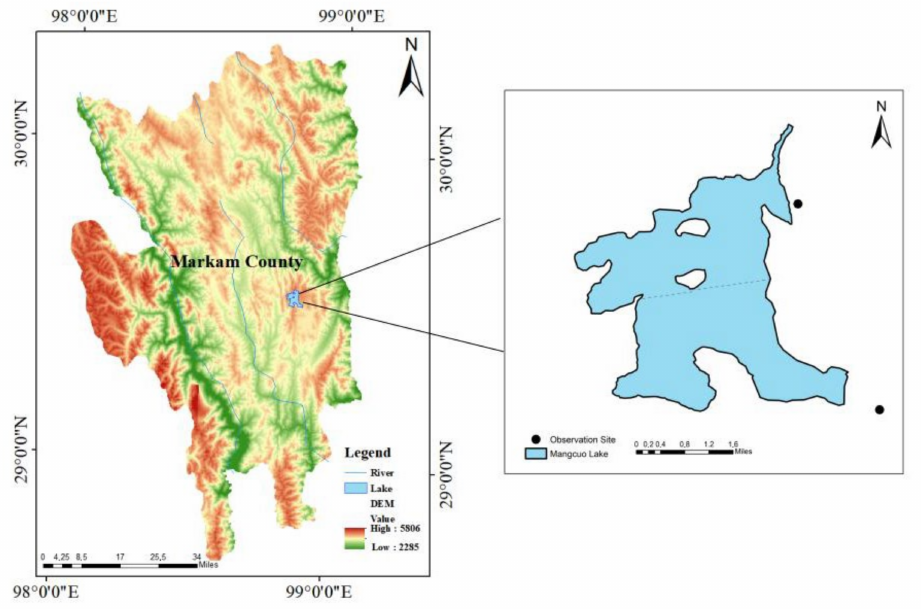
Figure 2. Observation sites and zoning at Mangcuo